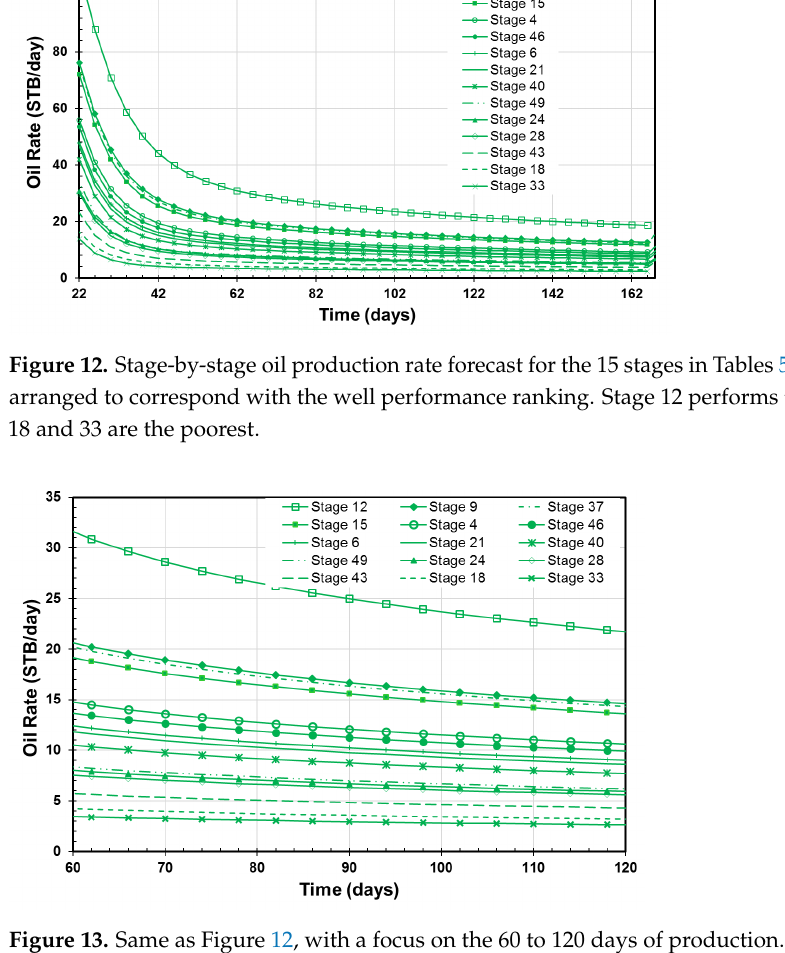
Figure 13. Same as Figure 12, with a focus on the 60 to 120 days of production.